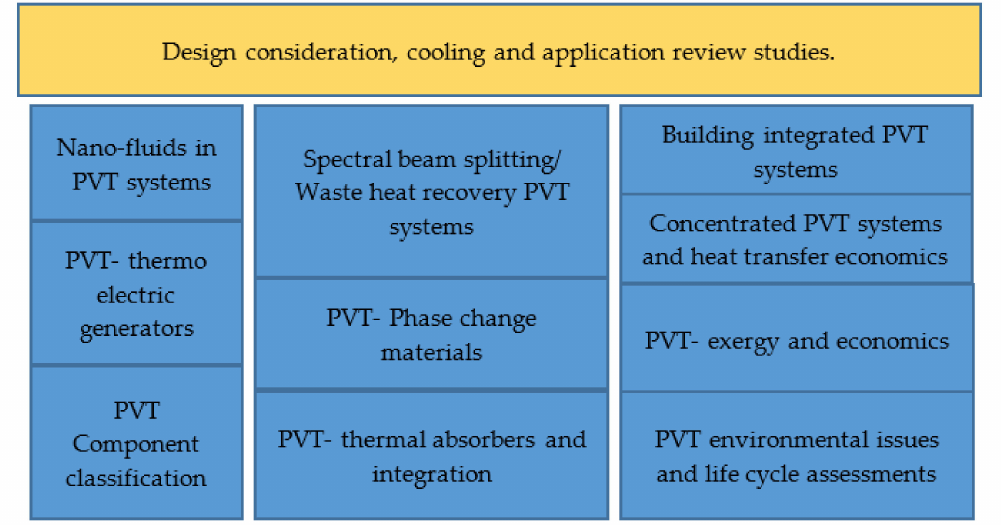
Figure 5. Summary of the topics covered in previous review